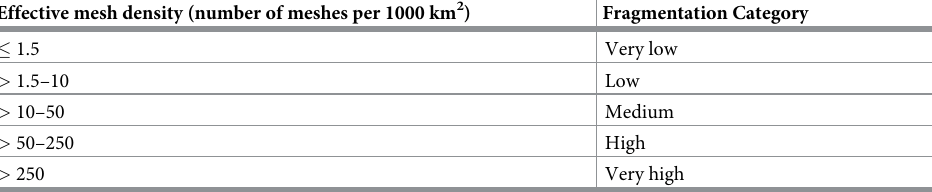
Table 3. Categories of effective mesh density ( seff ). In contrast to the EEA [46], the fragmentation categories "anthropogenic" and "very high" were combined into one category “very high” due to the relatively small number of N2k sites within the anthropogenic